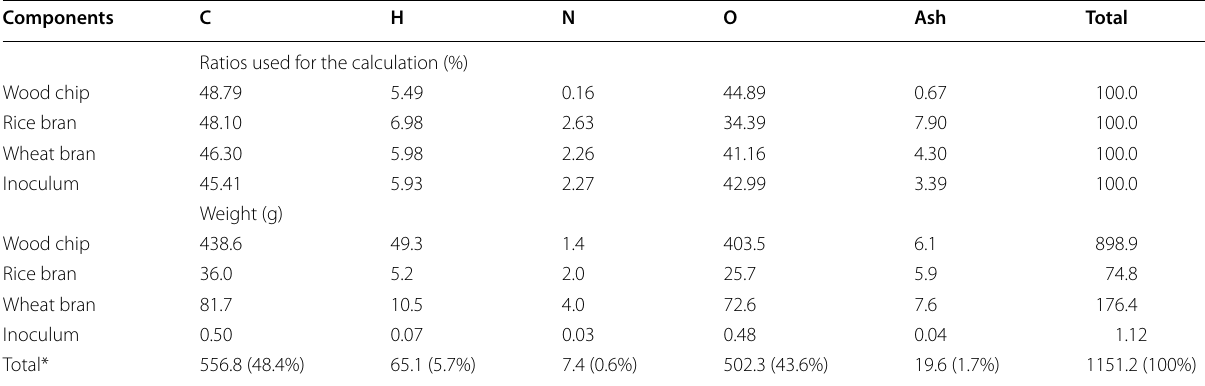
* Values in parentheses are a percentage of the total weight